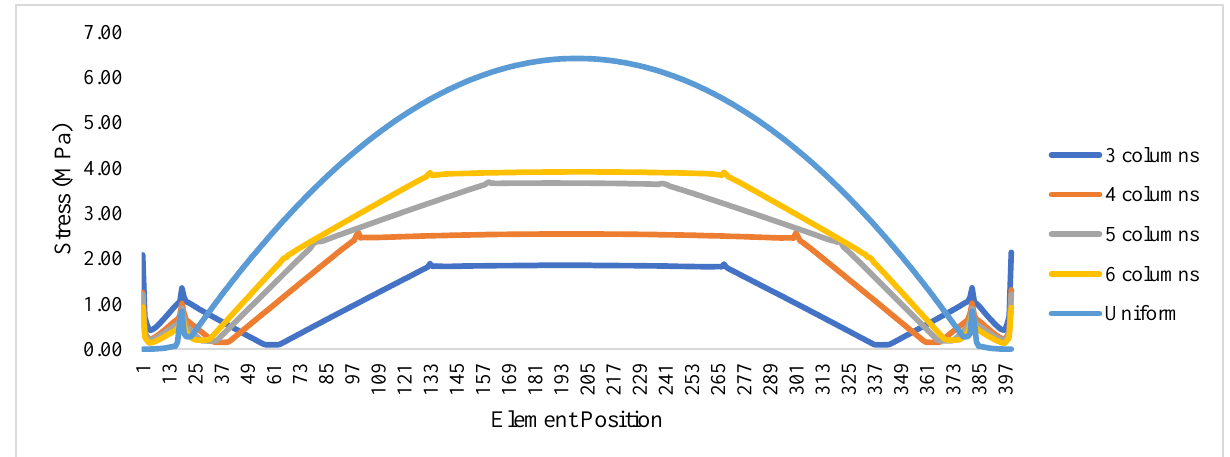
Figure 3. Plot of the equivalent Von Mises stress (Pa) of the pallet analog under uniformly distributed loading of 4.14 kPa.